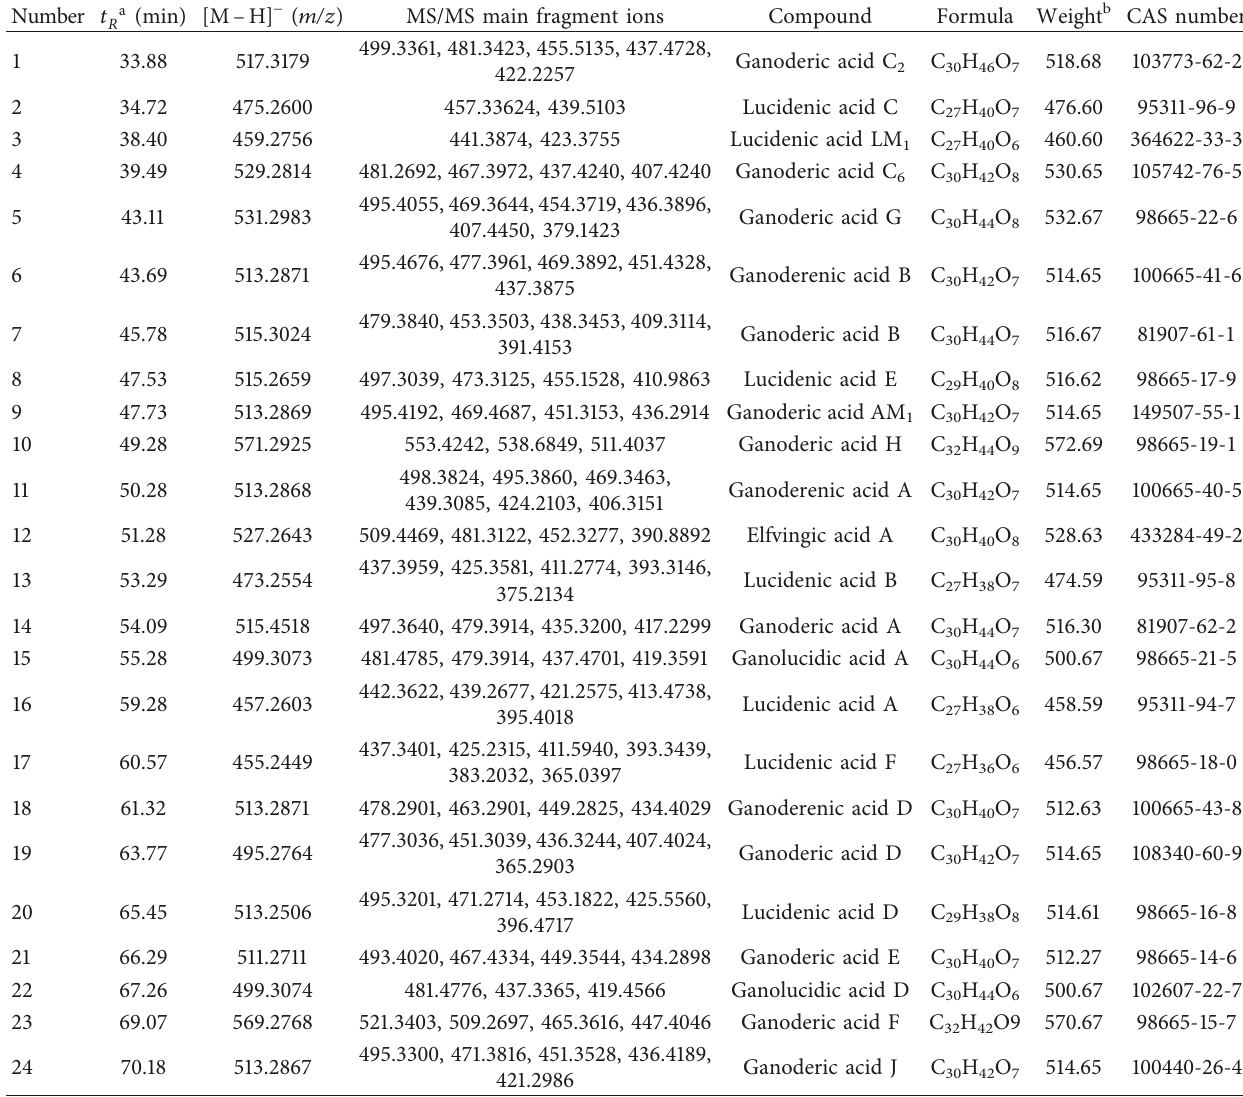
Table 1: Compounds identified in triterpenoids from Ganoderma